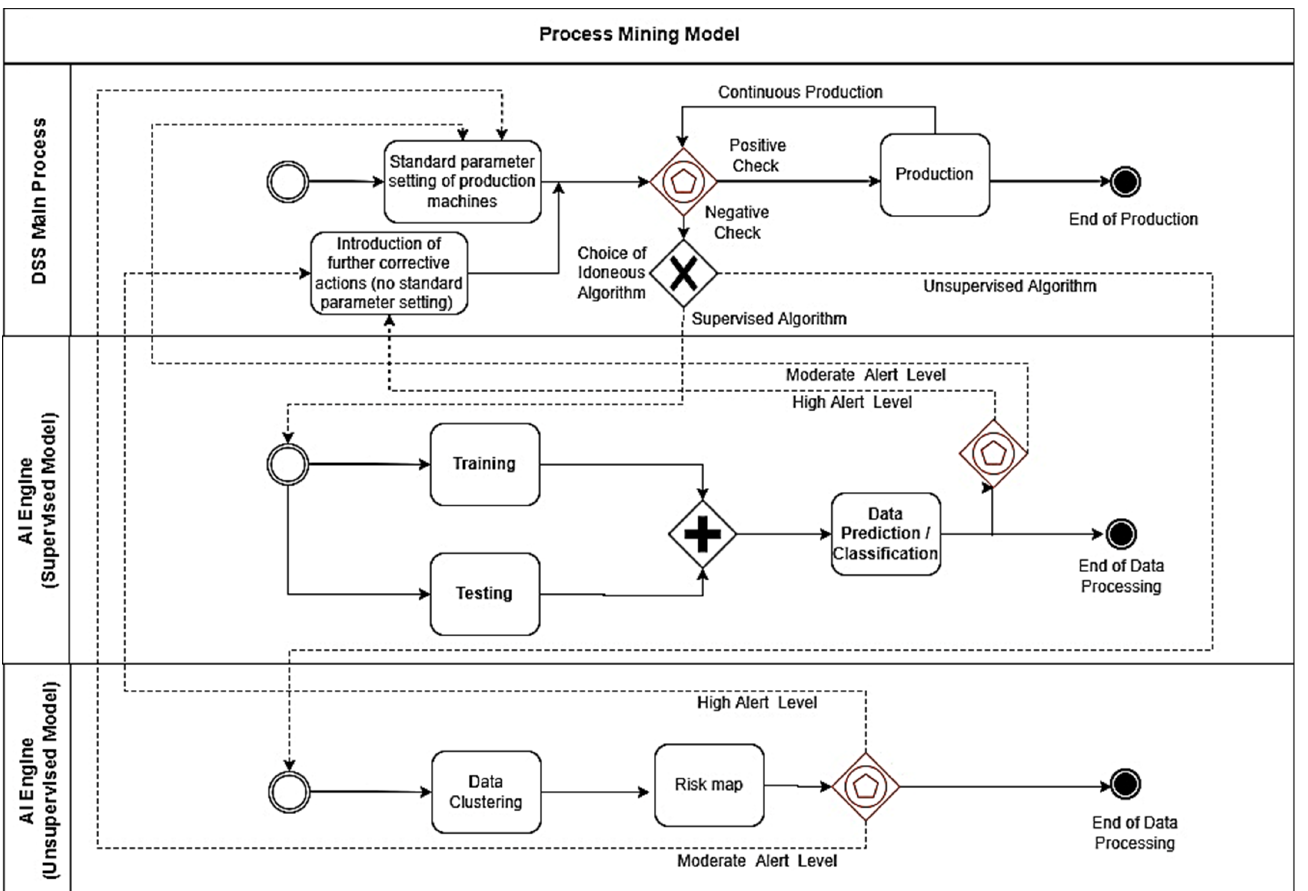
Figure 2. Proposed BPMN Process Mining (PM) theoretical model structured in three pools and integrating artificial intelligence algorithms (PM-AI): DSS main process and AI engine sub-processes behaving as feedback systems and providing decisions about the setting of machine parameters and about further machine corrective actions. In red are the BPMN symbols behaving as process checkpoints (“Exclusive Event based” gateways). The model indicates two alerting levels (moderate alert level and high alert level). The model can be made more complex by considering more alerting levels defining risk maps with more risk levels.